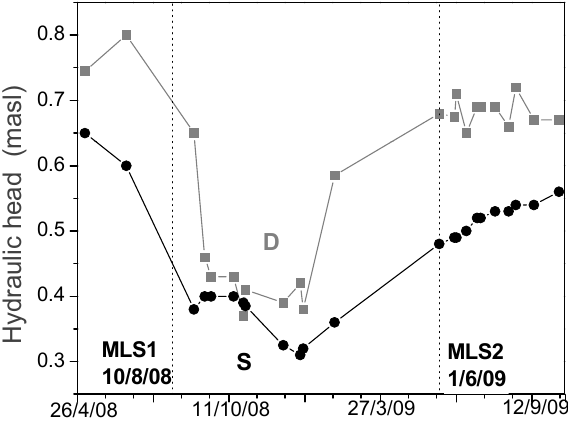
Fig. 5. Elevation of the hydraulic heads observed in the deep sub- aquifer in gray (measured in pipe D, Fig. 2) and the shallow sub- aquifer (measured in pipe S, Fig. 2). The dotted vertical lines de- note the retrieval dates of MLS1 and MLS2. ma.s.l. – meters above sea level. Fig. 6. Electrical conductivity (EC) monitored in a 35cm packed- off section of the observation well at 31.5m below ground level. Note the sharp change in EC on day 12, suggesting a relatively fresh water body flowed through the monitored